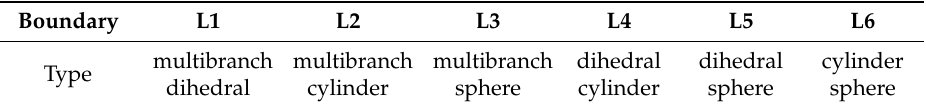
Table 1. The types of six boundaries.